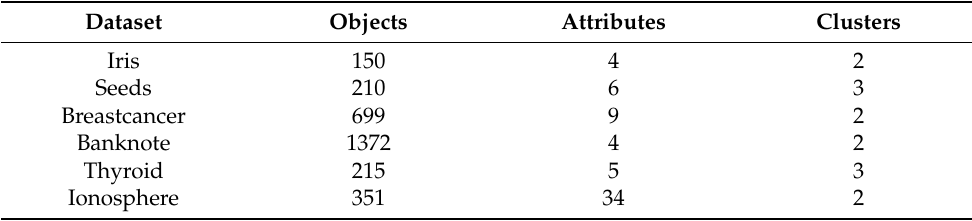
Table 2. The basic information of the six UCI data